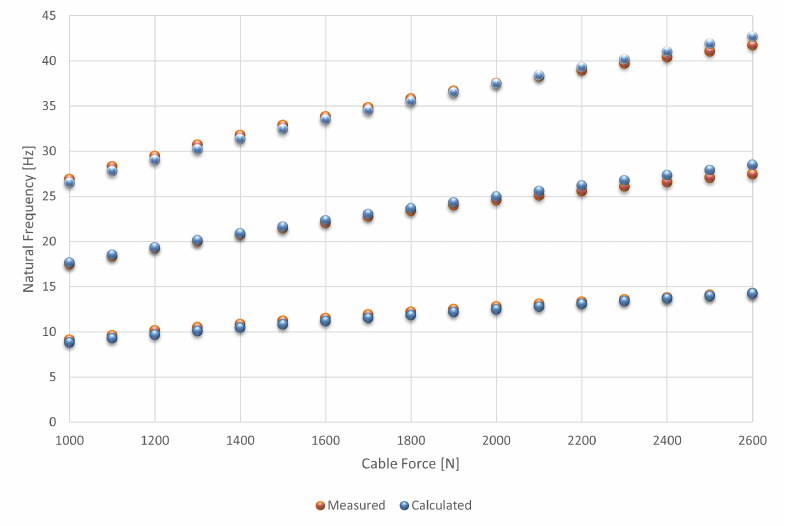
Figure 13. Comparison between the measured and calculated natural frequencies of the first three modes as a function of the cable load (2-D